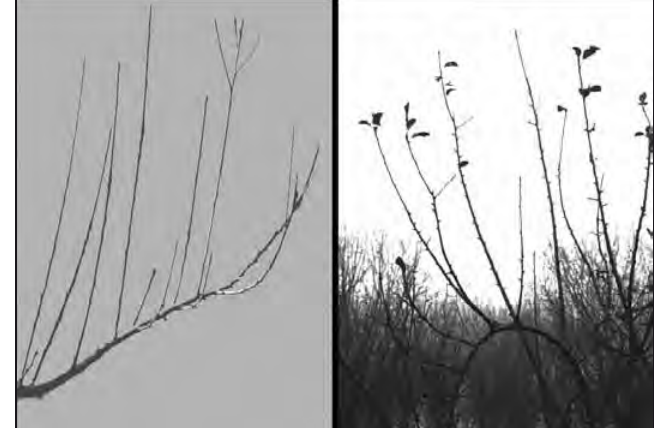
Fig. 4 - Development of lateral axes on an axis. Slanted parent axis of peach tree (left) and curved parent axis of apple tree